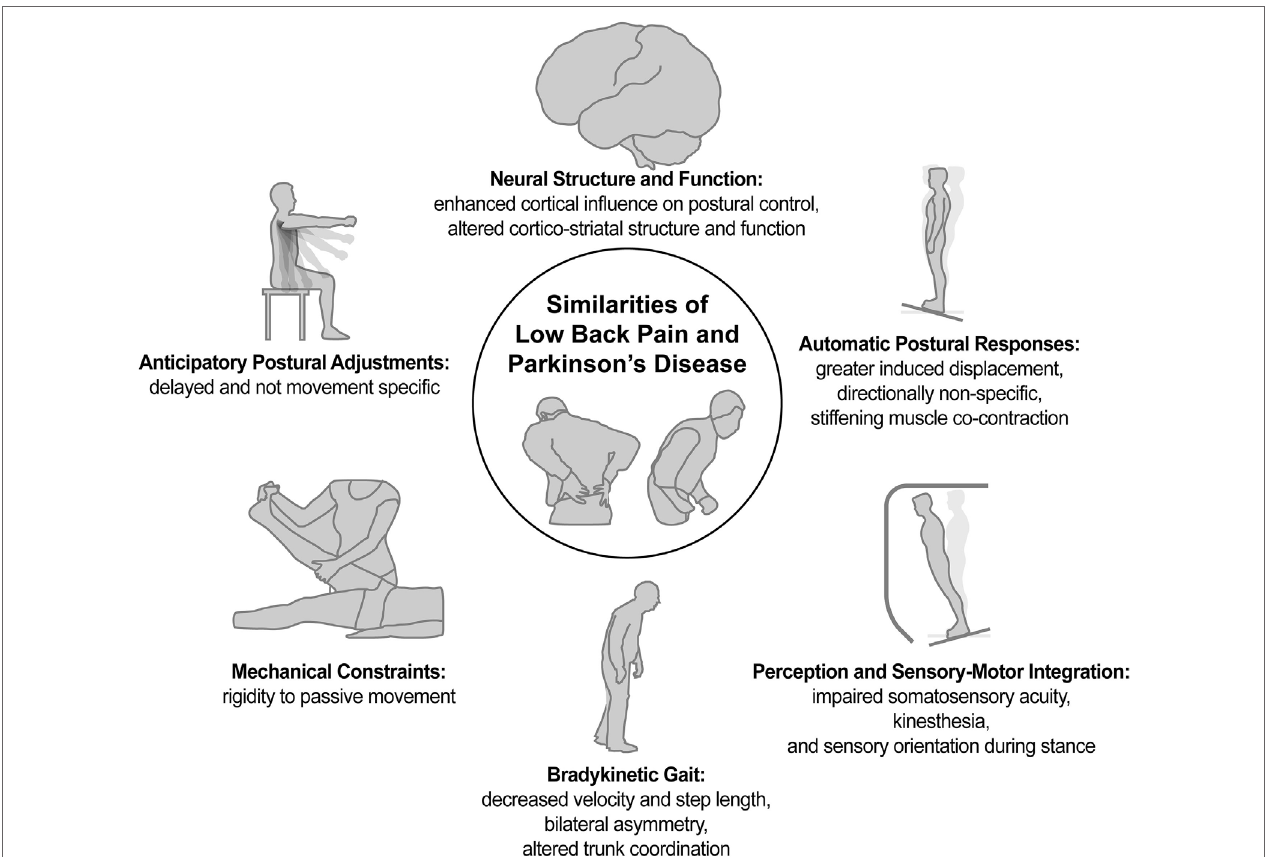
FiGUre 1 | Similarities of low back pain and Parkinson’s